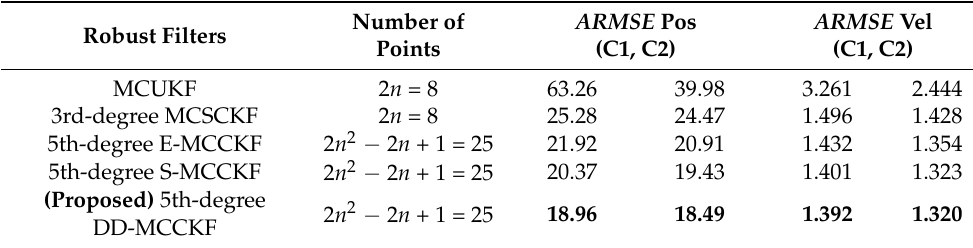
Table 3. Number of points used by different filtering algorithms in Experiment 1, along with the ARMSE for the position and